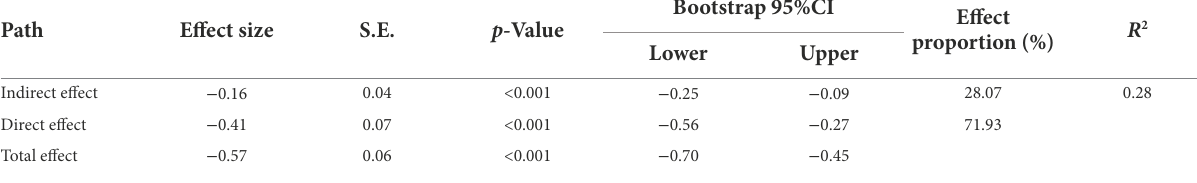
TABLE 4 The indirect effect, direct effect, and total effect of the mediation